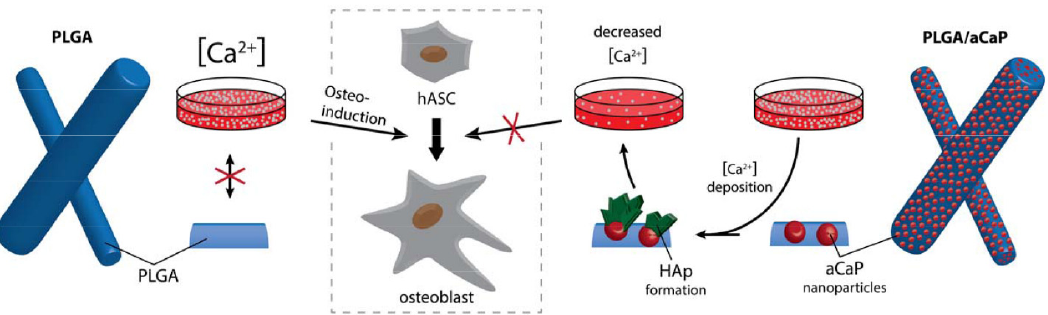
Figure 5. Studying potential bone grafts is often performed under in vitro conditions. Highly osteoconductive materials lead to the rapid formation of calcium phosphate crystal hydroxyapatite (HAp). In consequence, the free calcium ion in the medium depletes. In such cases, in vitro studies are not able to mimic in vivo conditions anymore, since continuous supply of minerals, such as Ca 2+ , is given by diffusion under in vivo conditions.